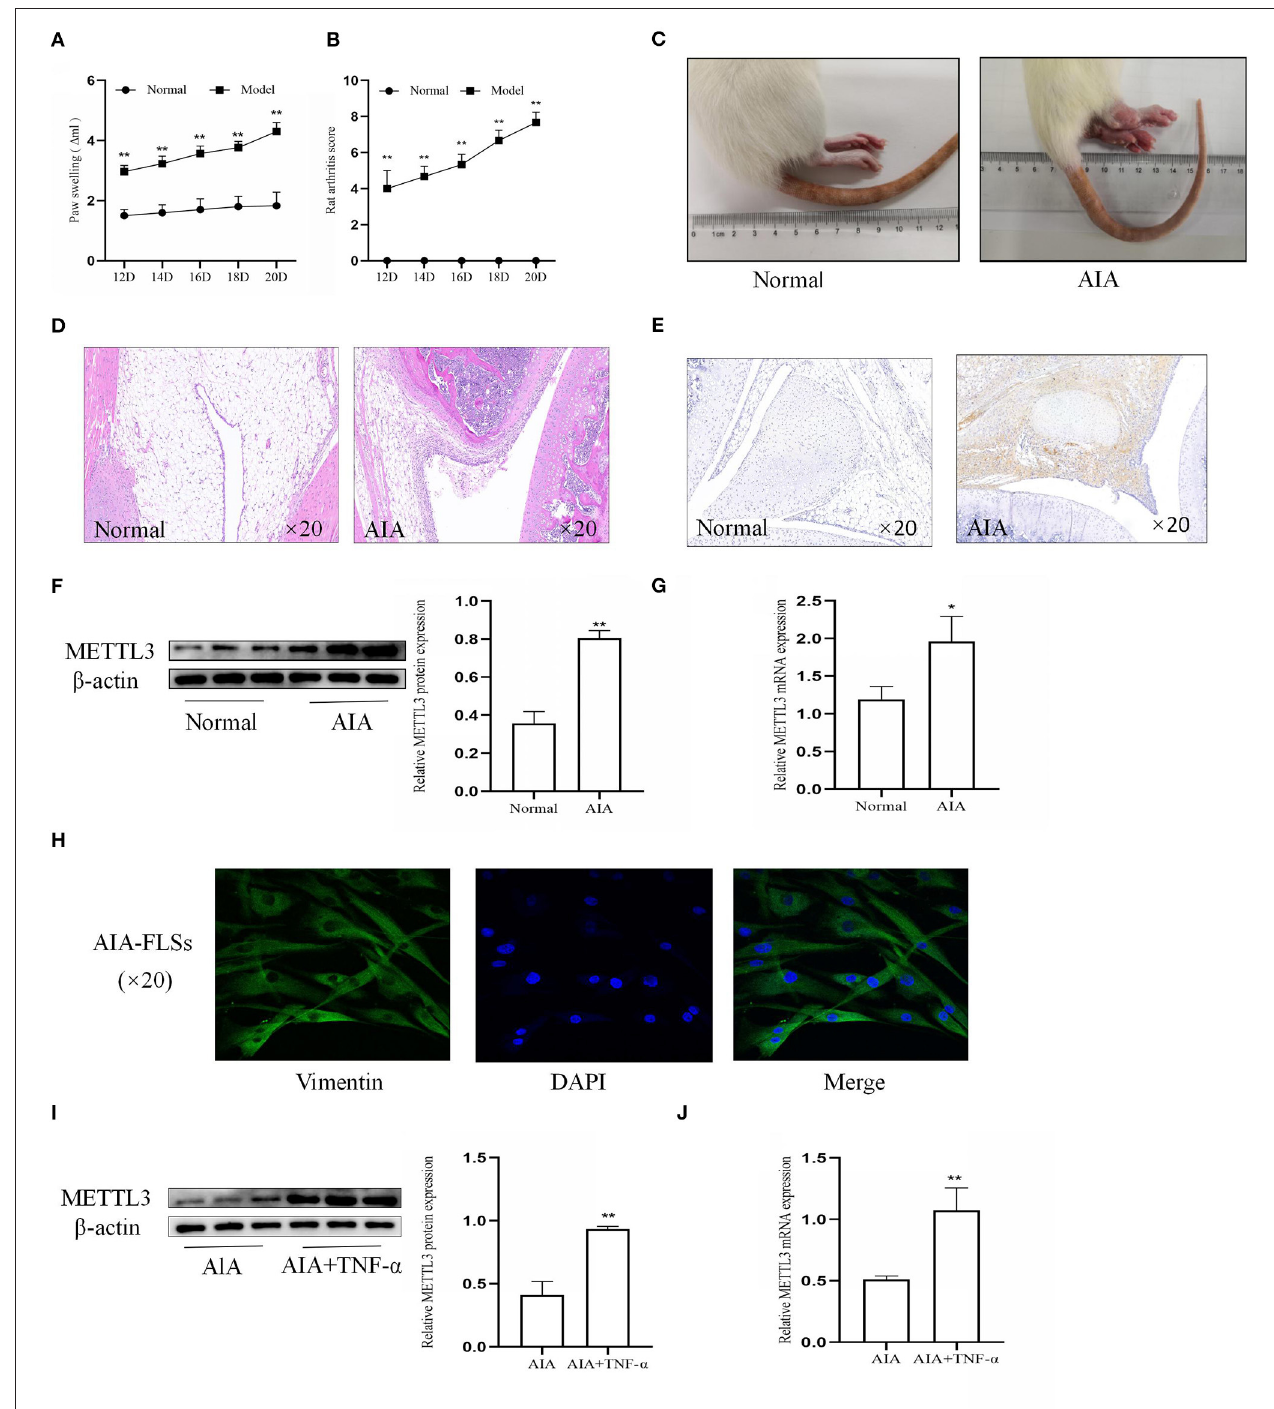
FIGURE 2 | Methyltransferase-like 3 (METTL3) expression was significantly upregulated in adjuvant-induced arthritis (AIA). (A) Ankle joint swelling based on Plethysmometer measurements. (B) Arthritis scores were extremely increased in the AIA model group. (C) Representative photographs of morphology in the normal group and the AIA model on day 24 after complete Freund’s adjuvant (CFA) induction. Typical photos were taken. (D) H&E staining of synovial tissues in the normal group and AIA group (original magnification, × 20). (E) METTL3 expression in the normal and AIA groups, as detected by immunohistochemical staining (original magnification, × 20). (F) Western blotting was used to measure METTL3 protein levels in normal and AIA synovial tissues. (G) METTL3 mRNA level was detected by real-time quantitative PCR (qPCR) in normal and AIA synovial tissues. (H) Cell identification, as detected by immunofluorescence (original magnification, × 20), vimentin expression, and morphology, showed that the extracted cells were AIA fibroblast-like synoviocytes (FLSs). (I) METTL3 protein levels in AIA-FLSs after treatment with TNF- α , as detected by Western blotting. (J) qPCR was used to measure METTL3 mRNA levels in AIA-FLSs after treatment with TNF- α . There were six rats in the normal group as well as in the model group. All of these values are presented as the mean ± SD. NC , negative control. * P < 0.05, ** P < 0.01 vs. the normal group.